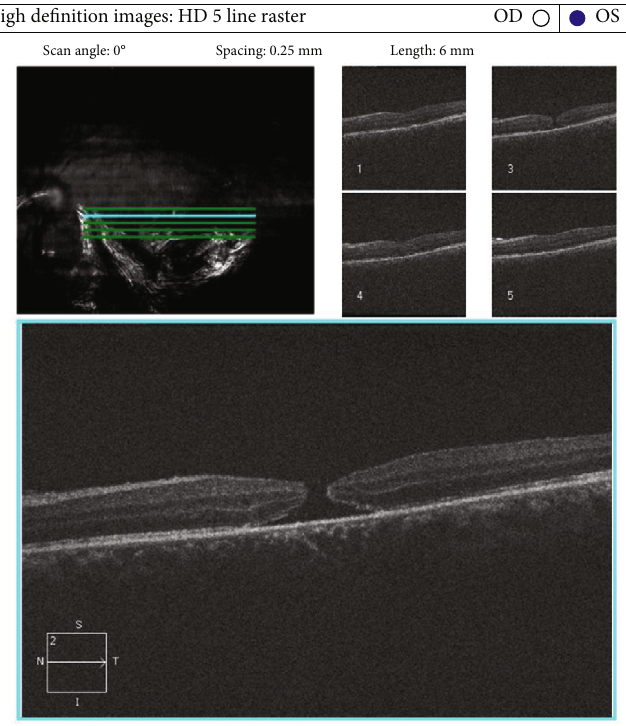
Figure 2: OCT showing development of